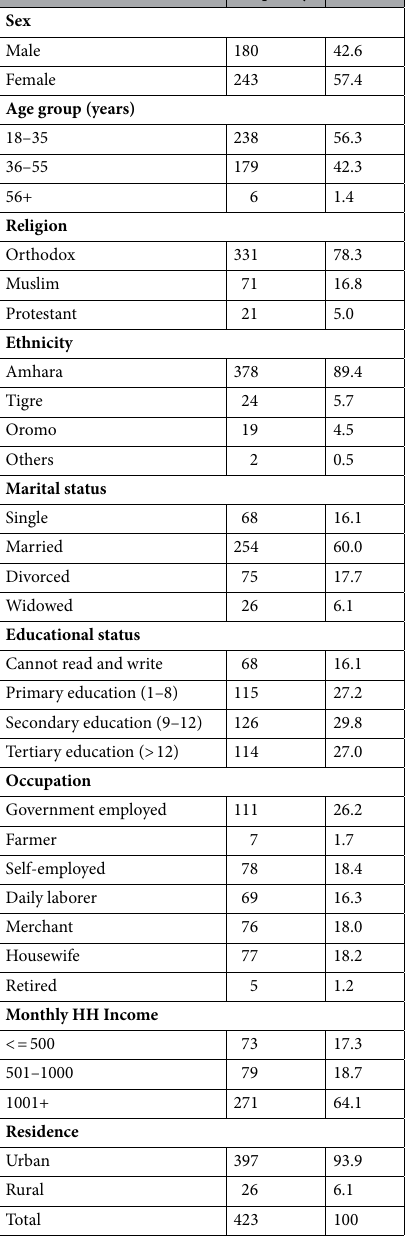
Table 1. Sociodemographic characteristics of the study participants in ART clinics of Bahir Dar, 2017 (N =